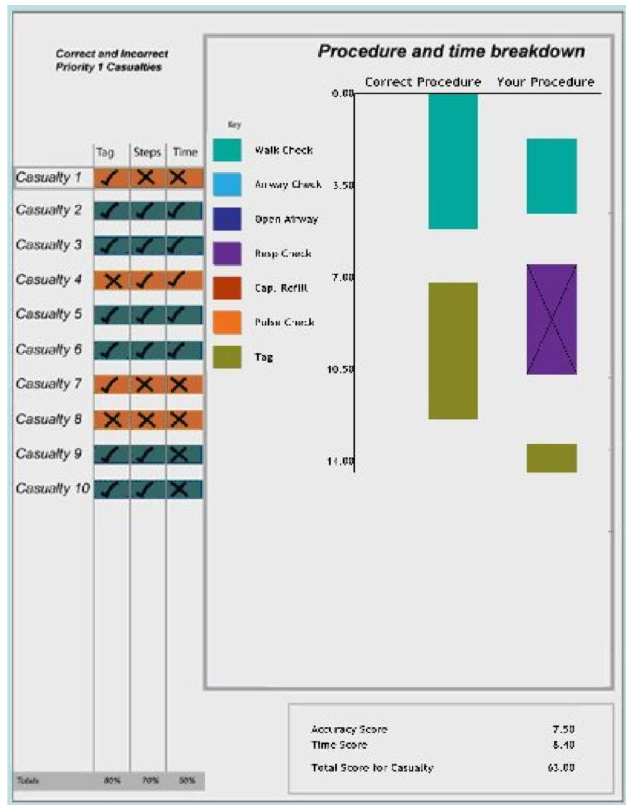
Figure 1. Feedback for pilot.